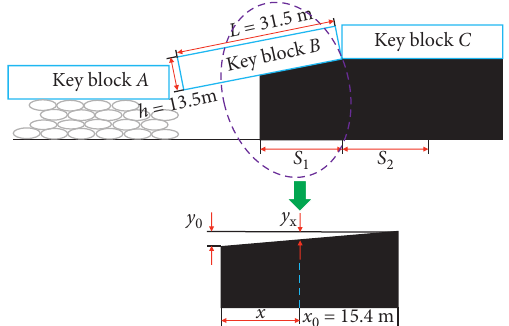
Figure 7: Breakage structure model of key